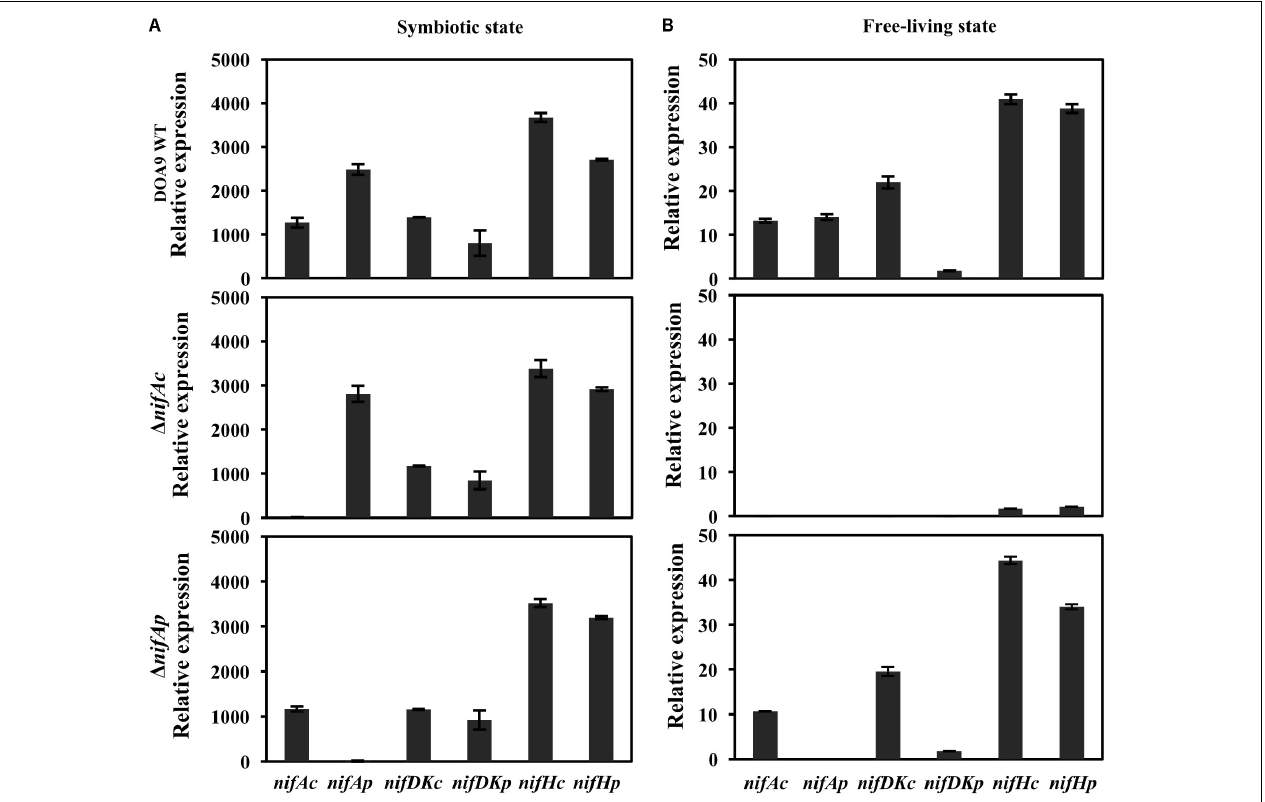
FIGURE 4 | Expression of nitrogen-fixing genes ( nifDKc , nifDKp , nifHc , and nifHp ) and nifAc , nifAp genes in Bradyrhizobium sp. DOA9 (WT) and nifA mutant strains grown under symbiosis (A) or free-living conditions (B) . Bacteroid cells were obtained from A. americana nodules at 20 days post-inoculation (A) , and bacterial cells grown under free-living conditions were obtained after 7 days of culture in BNM-B medium without glutamate (B) . Total RNA was extracted and subjected to quantitative reverse transcription-PCR (qRT-PCR) with an internal standard of dnaK . All data were from one representative experiment that was repeated three times. Error bars indicate standard